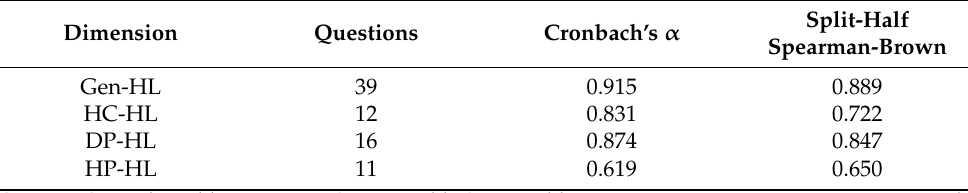
Table 2. Reliability of CPHLQ-Physical Part. Dimension